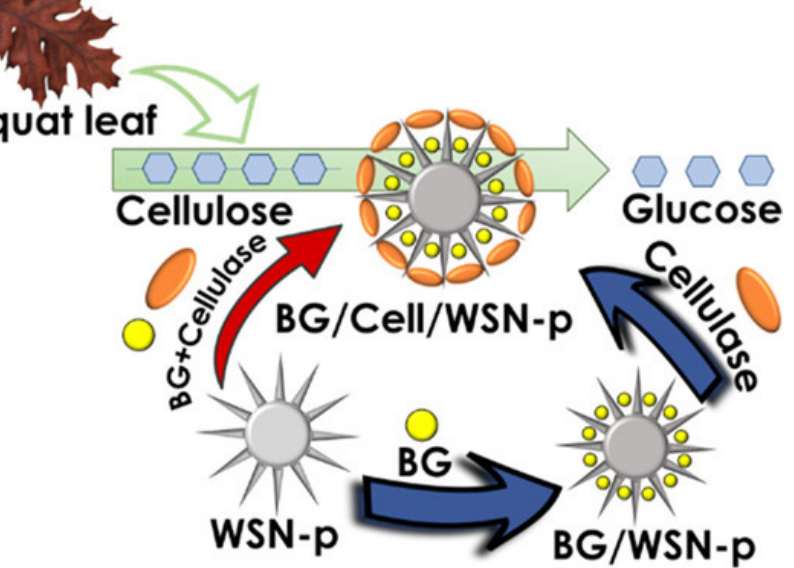
Figure 5. Schematic representation of the biomass waste hydrolysis to glucose with the nanobiocat- alyst containing two enzymes adsorbed on sophisticated porous silica NPs. Reproduced with permission from [27], American Chemical Society, 2022.